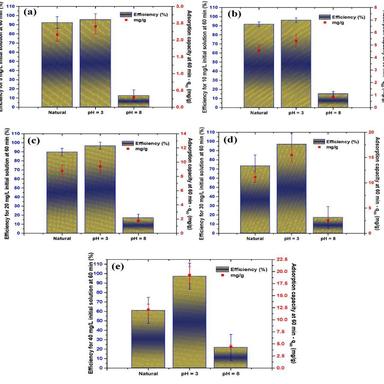
Efficiency of the adsorption process under different pH values for initial CR concentration of (a) 5 mg/L, (b)10 mg/L, (c) 20 mg/L, (d) 30 mg/L and (e) 40 mg/L. (A colour version of this figure can be viewed online.)